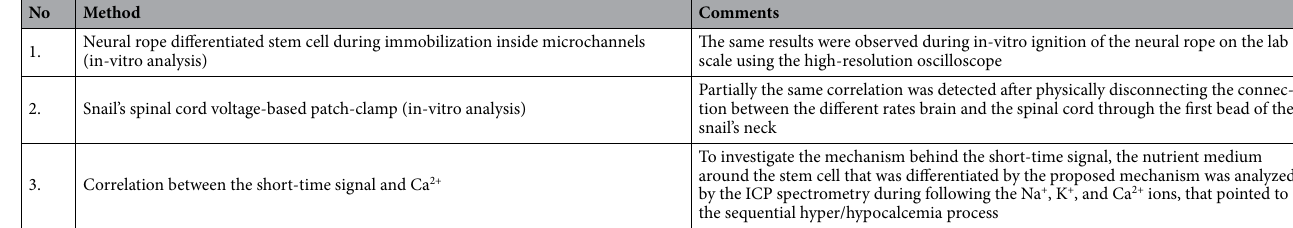
Table 2. Summary of the adopted experiments for approaching to the mechanistic behavior of the neuronal electrical